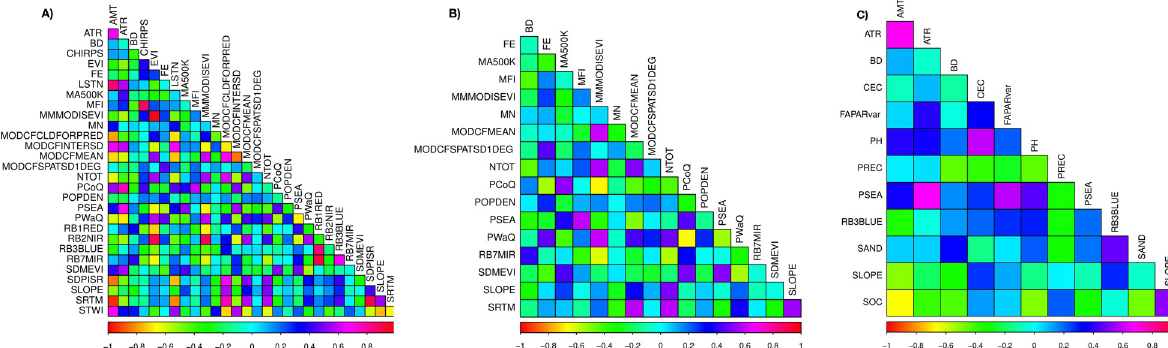
Fig 3. Correlation among selected covariates A) 29 covariates after recursive feature elimination; B) 17 covariates with Pearson’s correlation coefficient (r) less than ± 0.7; C) 12 covariates selected using a subjective approach.